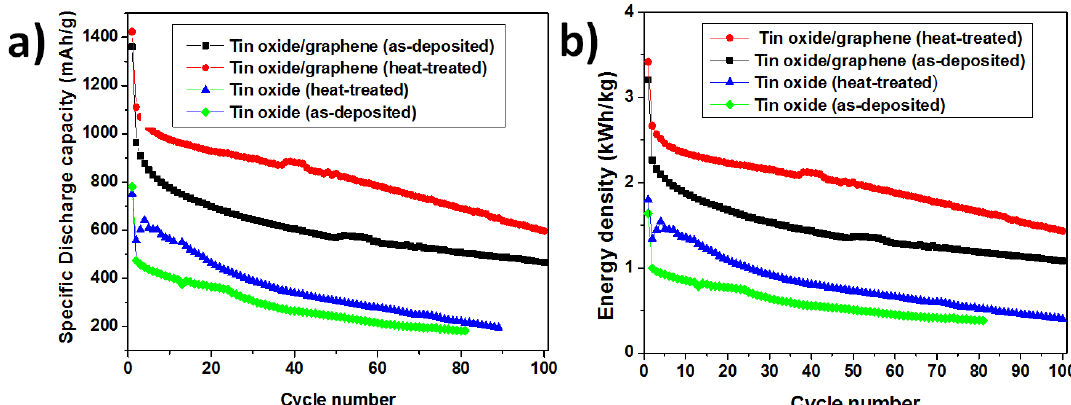
Figure 4. Comparison of ( a ) cycle performance and ( b ) energy density of tin oxide/graphene (TG) composites and tin oxide samples for both as-deposited and heat treated